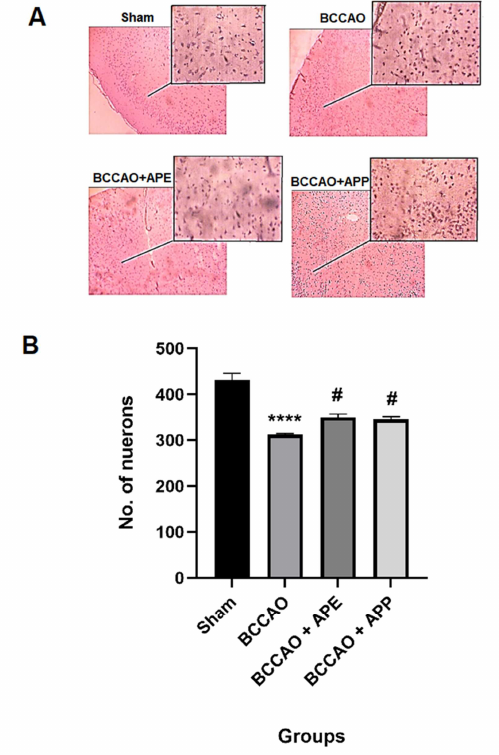
Figure 4. APE and APP pre-treatment reduced the brain motor cortex damage 24 h after ischemia/reperfusion in animals and improved the number of survival neurons compared to the BCCAO group ( A , B ). Micrographs (10× and 40×) of hematoxylin and eosin (H and E) stained brain tissue. Repeated measures one-way analysis of variance with Bonferroni post-hoc was used. **** p < 0.0001 vs. the sham group; # p < 0.05 vs. the BCCAO